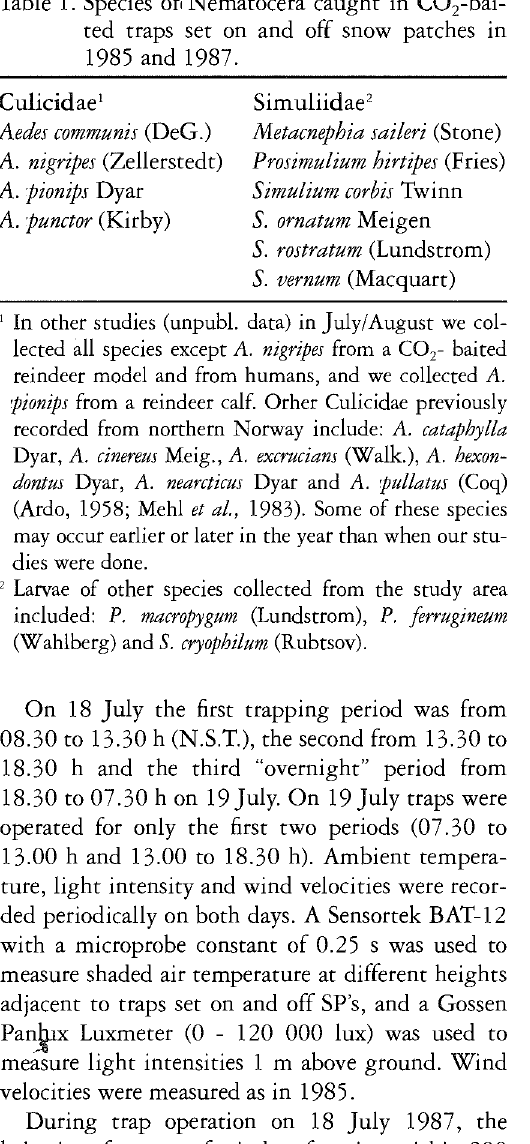
Table 1. Species of Nematocera caught in C0 ted traps set on and off snow patches in 1985 and 1987.